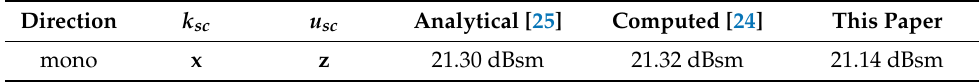
Table 1. Comparison of computed RCS (dBsm) of a spherical chaff cloud. Direction k sc u sc Analytical [25] Computed [24] This Paper